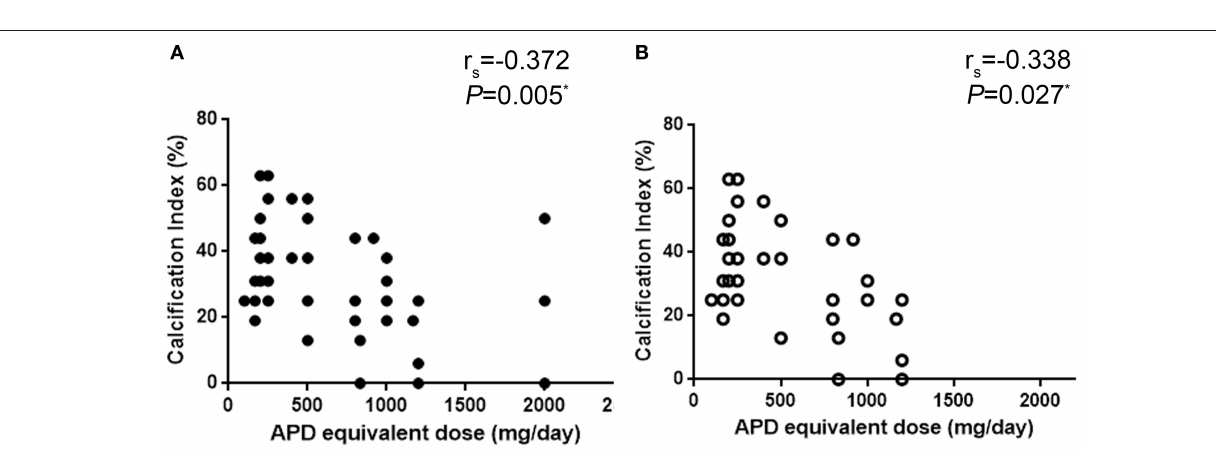
FIGURE 3 | Correlation analysis of equivalent APD dose and aortic calcification index. (A) all patient, (B) patients without olanzapine treatment. APD, antipsychotic